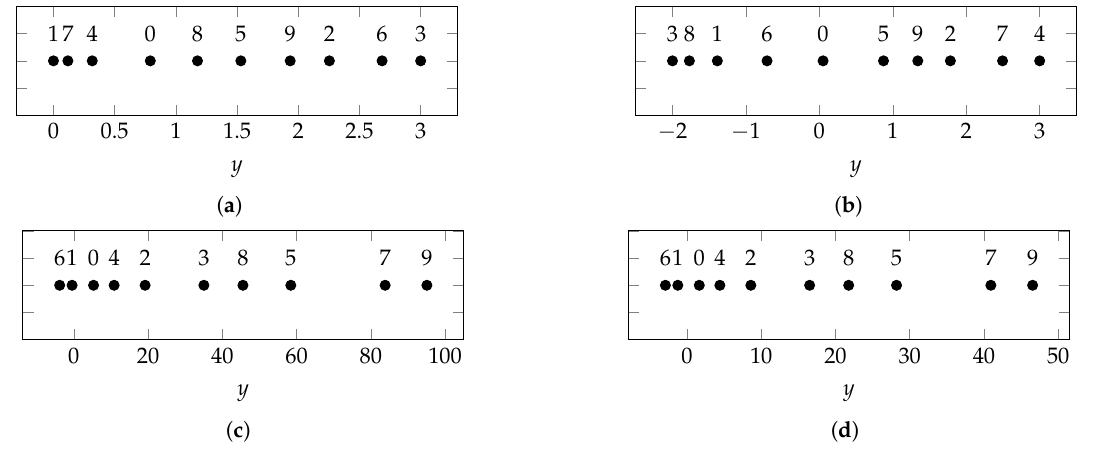
Figure 1. A total of 10 first univariate Leja nodes with respect to different truncated normal and (cid:0) (cid:1) µ , σ 2 , l , u Gumbel probability distributions. The truncated normal distributions are denoted with T N , where µ and σ 2 refer to the mean value and the variance of a normal distribution, while l and u are the lower and upper truncation limits. The Gumbel distributions are denoted with G ( (cid:96) , β ) , where (cid:96) is the location parameter and β the scaling parameter. The annotation above each node denotes the order of appearance in the Leja sequence, where “0” refers to the initial (cid:0) (cid:1) (cid:0) (cid:1) µ = 0, σ 2 = 1, l = 0, u = 3 µ = 0, σ 2 = 1, l = − 2, u = 3 node: ( a ) T N , ( b ) T N , ( c ) G ( (cid:96) = 3, β = 4 ) , ( d ) G ( (cid:96) = 0.5, β = 2 )